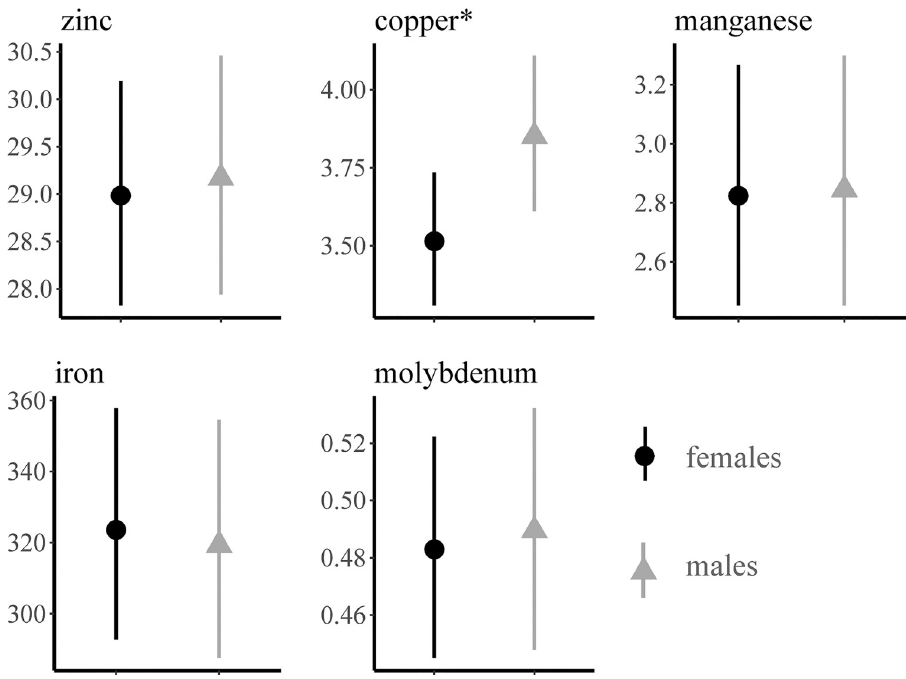
Fig 7. Mean liver concentrations (ppm, wet weight) of heavy metals in male and female muskrats ( Ondatra zibethicus ) in Pennsylvania, USA, 2018–2019. � Confidence interval of the mean difference does not overlap